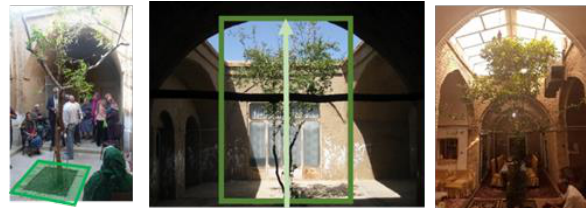
Figure 14. The examples of the trees and the garden in the homes.